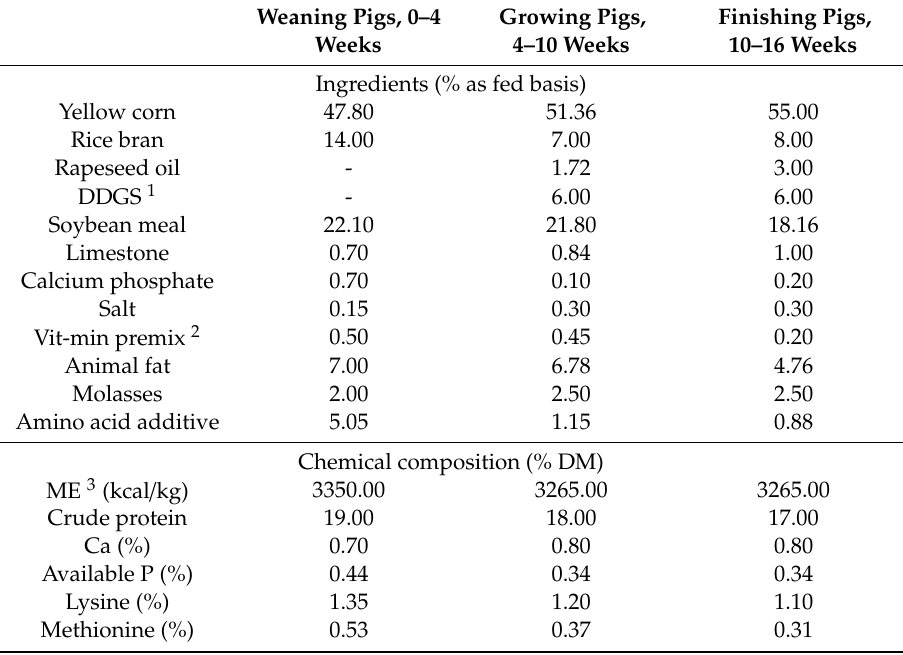
Table 1. Ingredients and chemical composition of the experimental